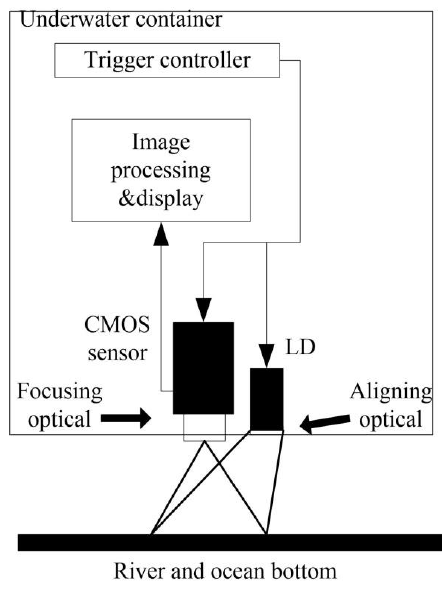
Figure 6. The framework of underwater image detecting system for field tests. Table 5. Physical properties of experimental system.